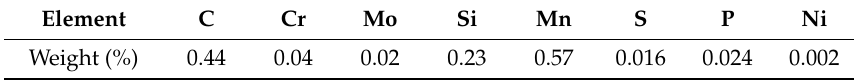
Table 1. Chemical composition of the medium-carbon steel.